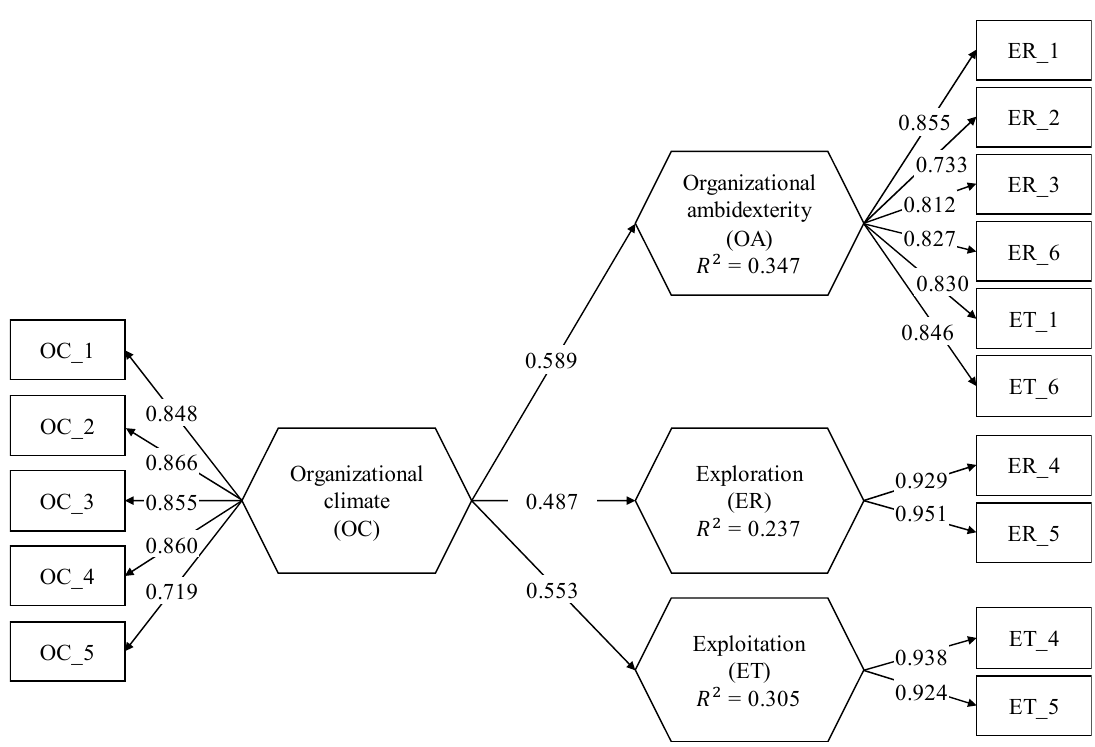
Figure 3. Results of the structural model.